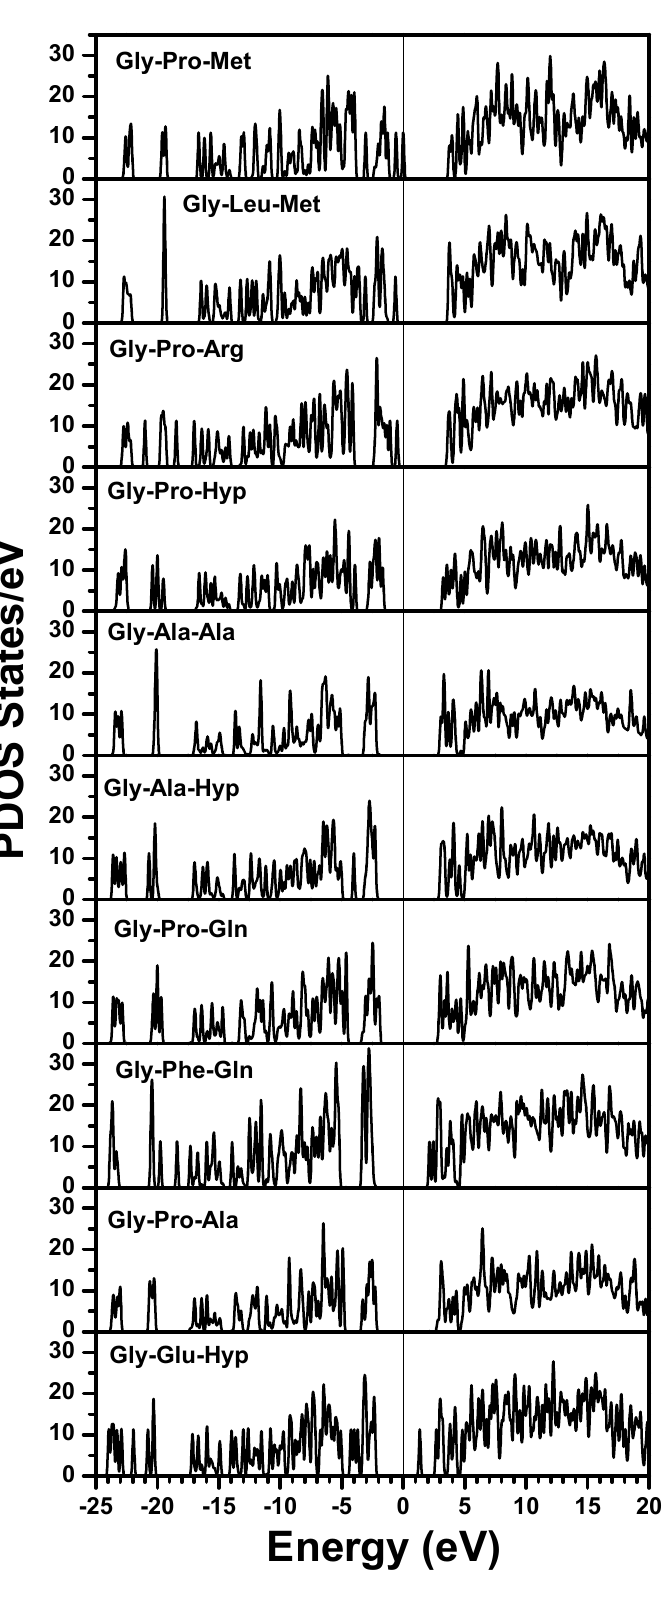
Figure 3. Calculated PDOS for each triplet in the α HOMO–LUMO gaps for different